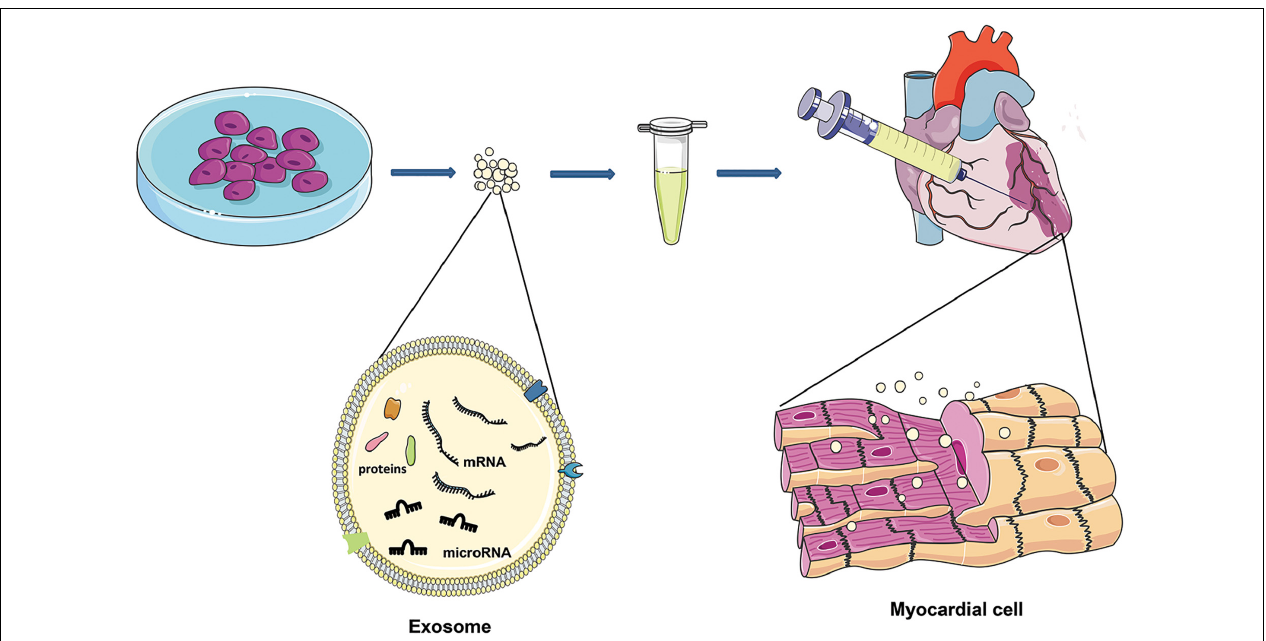
FIGURE 1 | After MI, exosomes of different cell sources are injected around the infarction site, and exosomes can enter the damaged cardiomyocytes to reduce cardiomyocyte death. Exosomes are characterized by lipid bilayers, transmembrane and non-membrane binding proteins, and a high concentration of nucleic acids (DNA, mRNA, microRNA, and lncRNA).